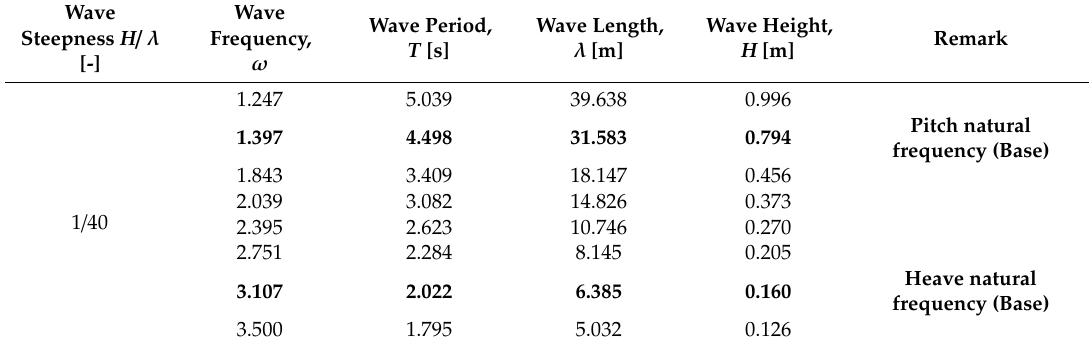
Table 5. Regular wave conditions.